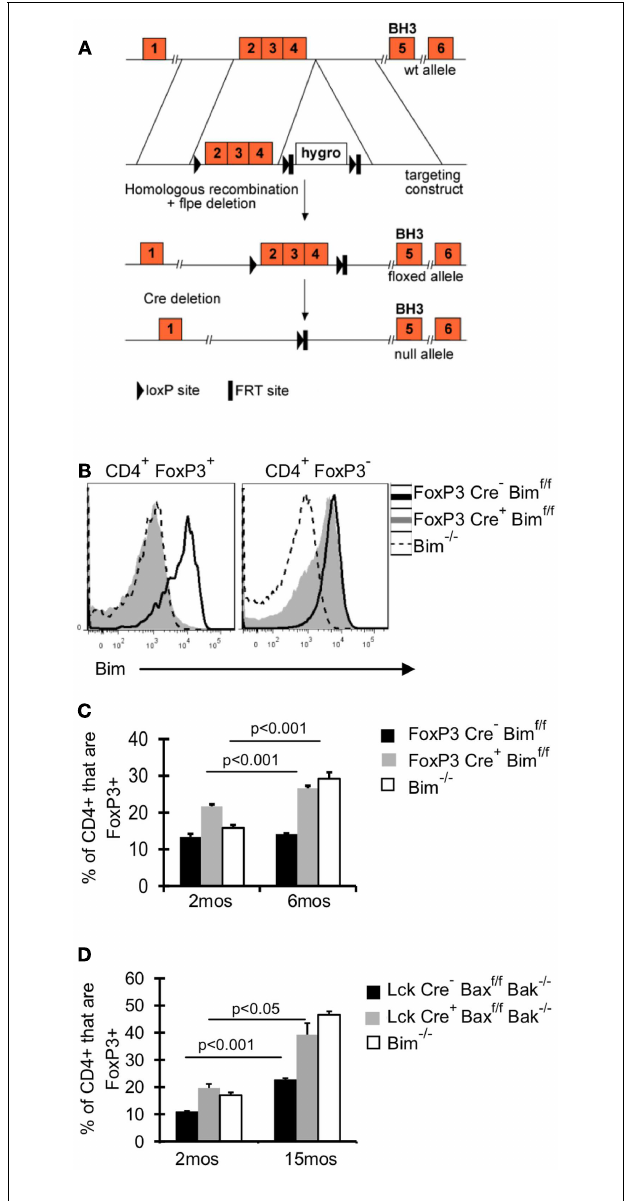
FIGURE 2 | Bim is the dominant BH3-only molecule inT reg and its effects onT reg homeostasis areT reg intrinsic . (A) A conditional Bim allele was generated by targeting loxP sites upstream of exon 2 and downstream of exon 4. (B,C) Cells from the lymph nodes of 2- and 6-month-old FoxP3-Cre − Bim f/f , FoxP3-Cre + Bim f/f , and Bim − / − mice were stained for CD4, FoxP3, and Bim and analyzed by flow cytometry. (B) Histograms show the expression of Bim in CD4 + FoxP3 + and CD4 + FoxP3 − T cells from 2-month-old mice. (C) Results show the frequency of CD4 + cells that are FoxP3 + in 2month ( n = 5/group) and 6-month-old mice ( n = 3–4/group; ± SE).The p values represent the difference between 2 and 6months (Student’s t test). Results are representative of two independent experiments. (D) Splenocytes from Lck-Cre − Bax f/f Bak − / − ( n =